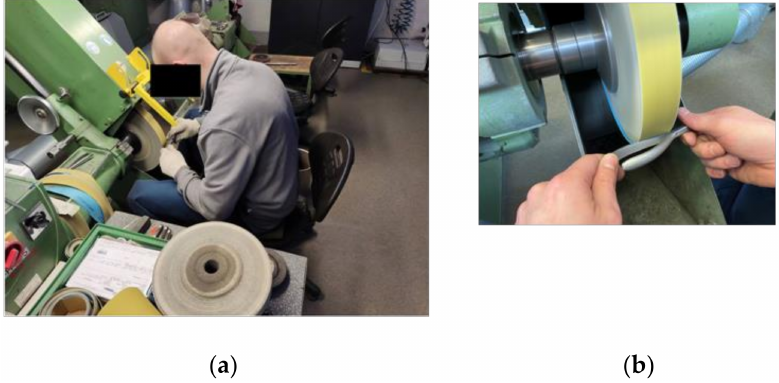
Figure 2. Manual belt grinding station: ( a ) overall view; ( b ) working